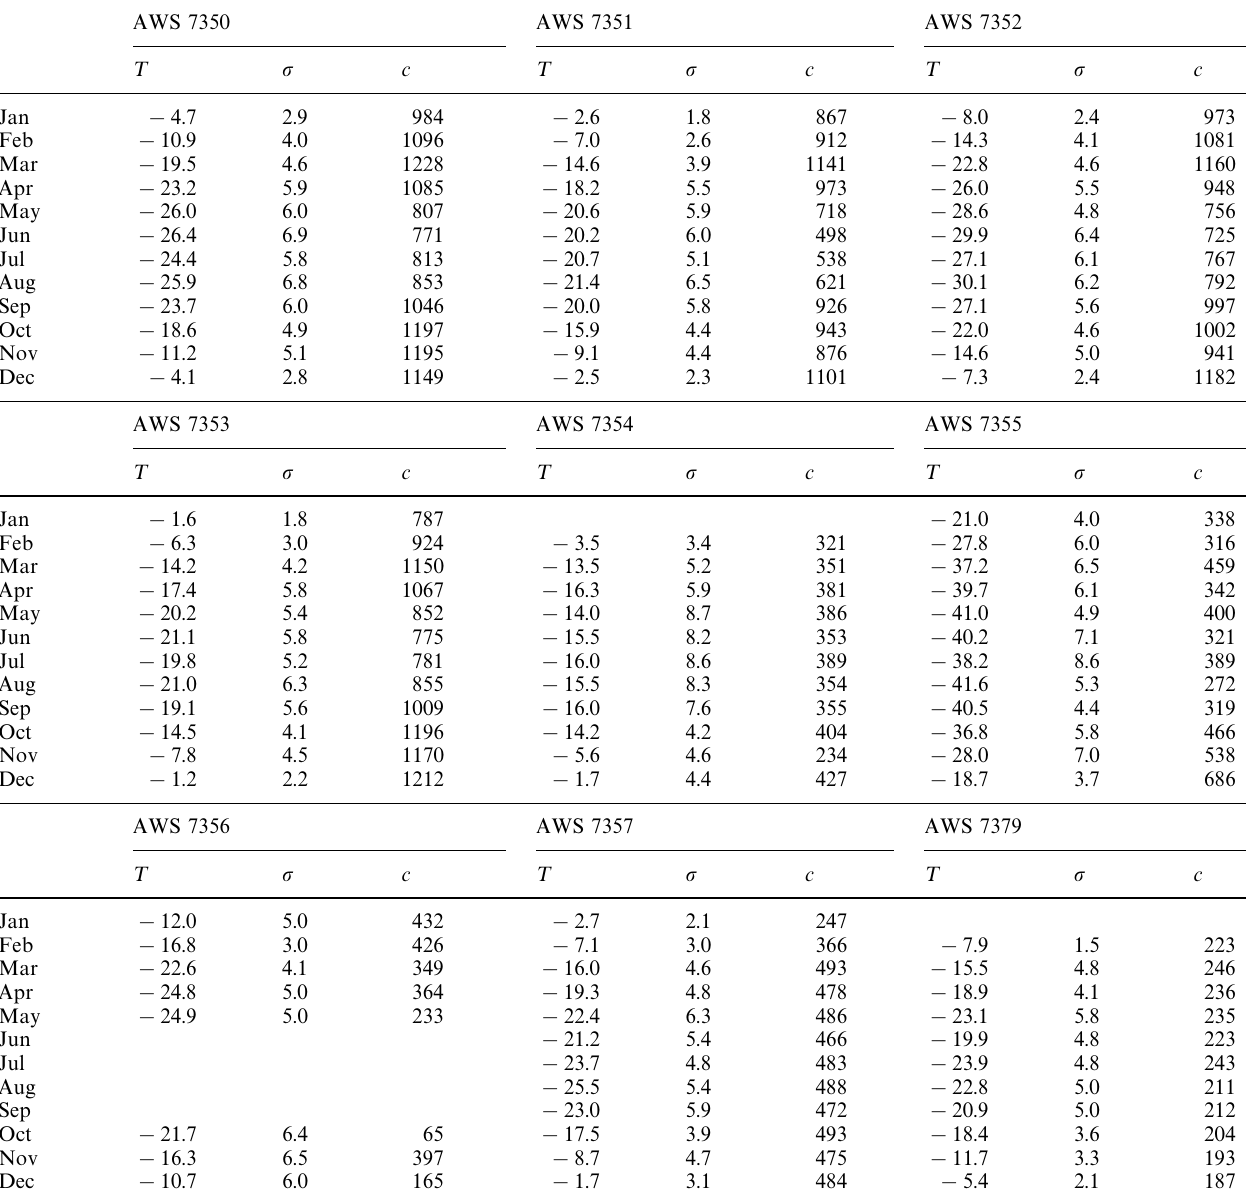
Table 2. Monthly average temperature ( ° C), standard deviation and number of cases at all AWS AWS